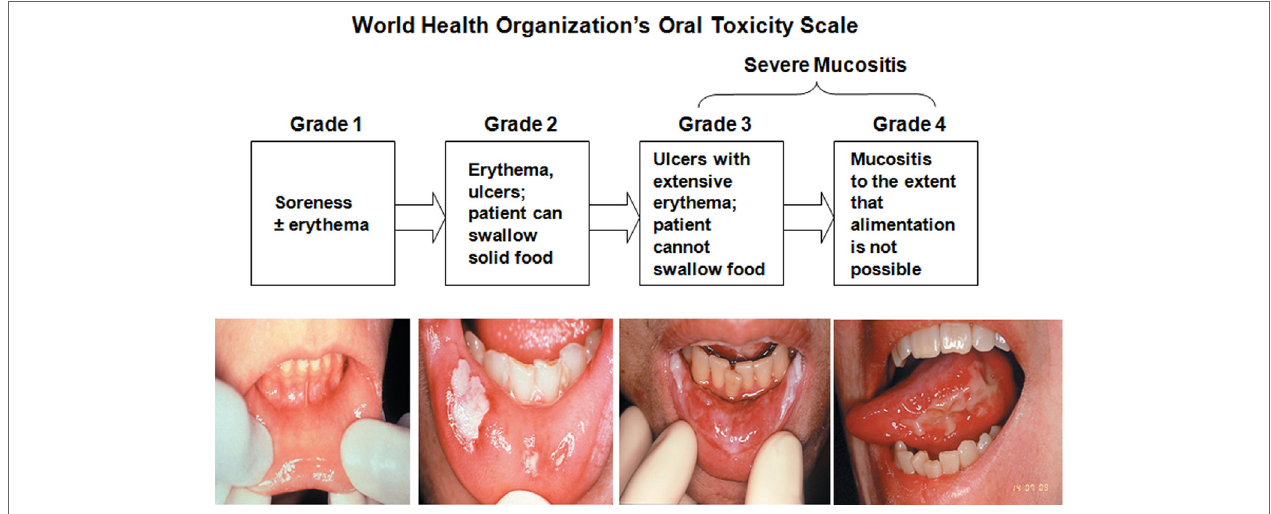
FiGuRe 4 | world Health Organization’s Oral Toxicity Scale . Republished with the permission of Dr. Patrick Stiff, Loyola University Medical Center, Maywood, IL, USA.